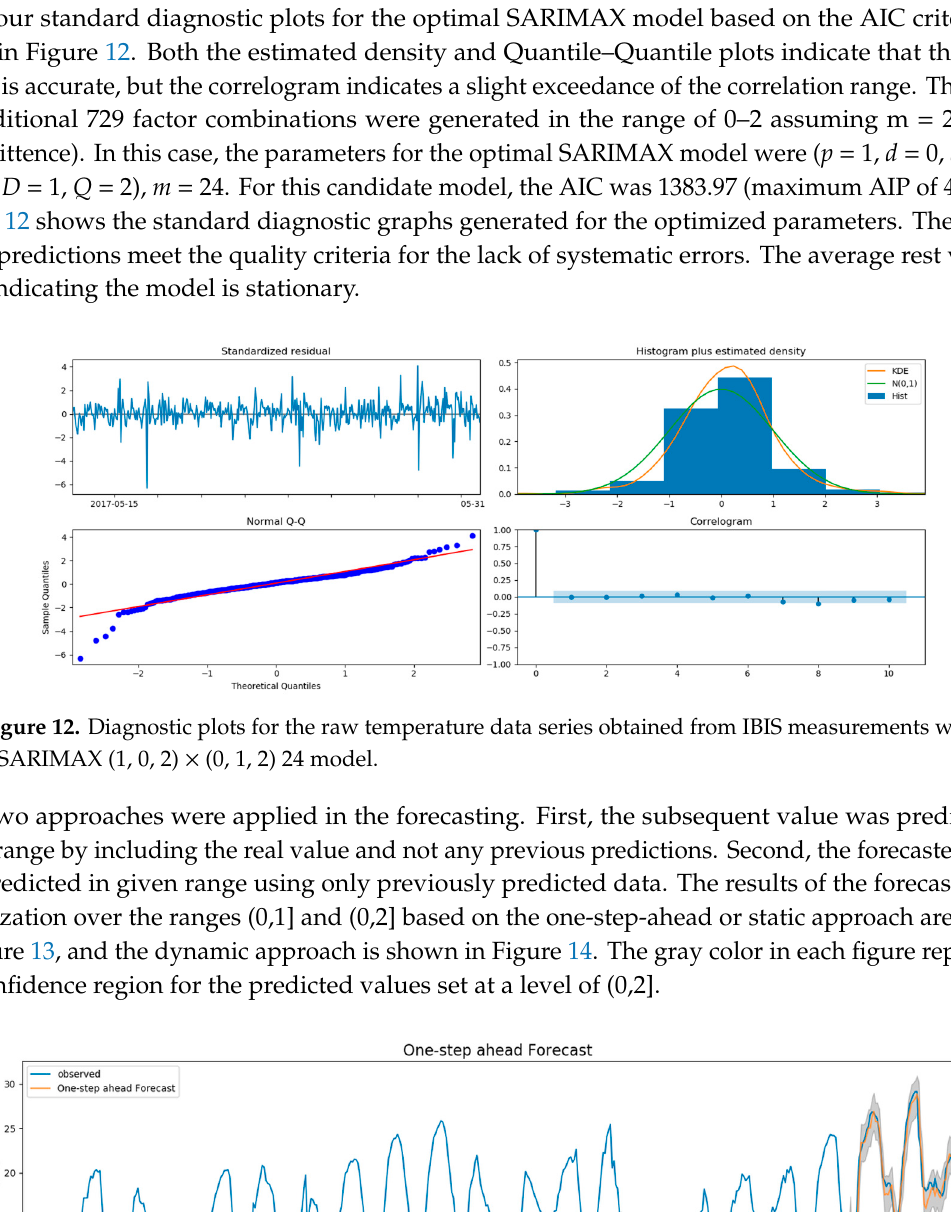
Figure 14. Training data and forecasting result in the dynamic mode for the raw temperature data time series obtained from the IBIS measurements for a SARIMAX (1, 0, 2) × (0, 1, 2) 24 model.